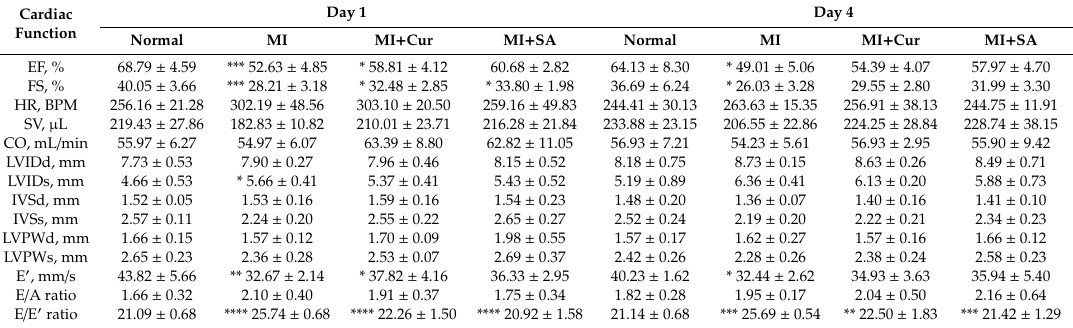
Table 2. Cardiac function measured by